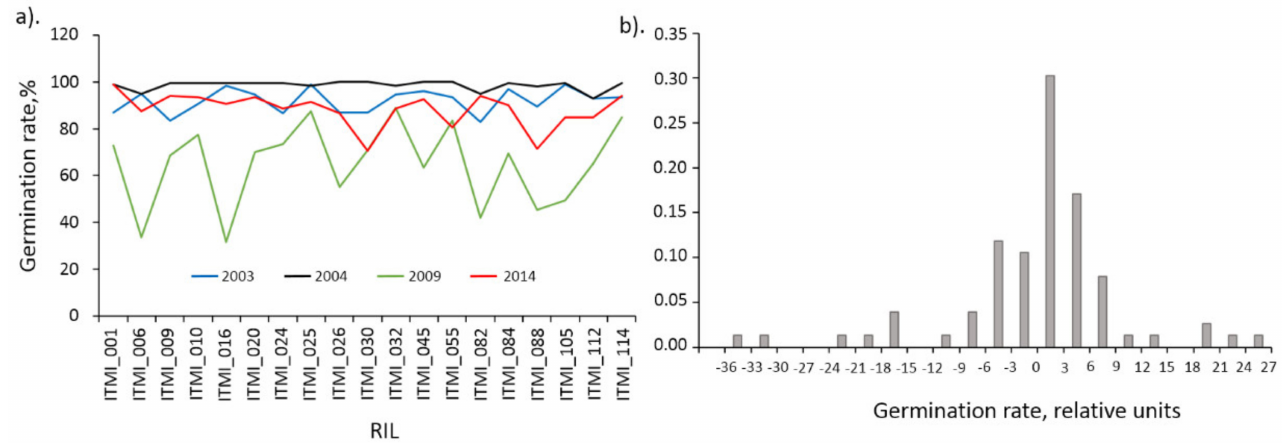
Figure 4. Germination of plants in the ITMI population for 19 genotypes evaluated in 2003, 2004, 2009, and 2014. ( a ) Germination values ( Y -axis) for genotypes ( X -axis) in different years shown by lines of different colors (see legend at bottom of graph); ( b ) Distribution of germination values after subtracting the annual